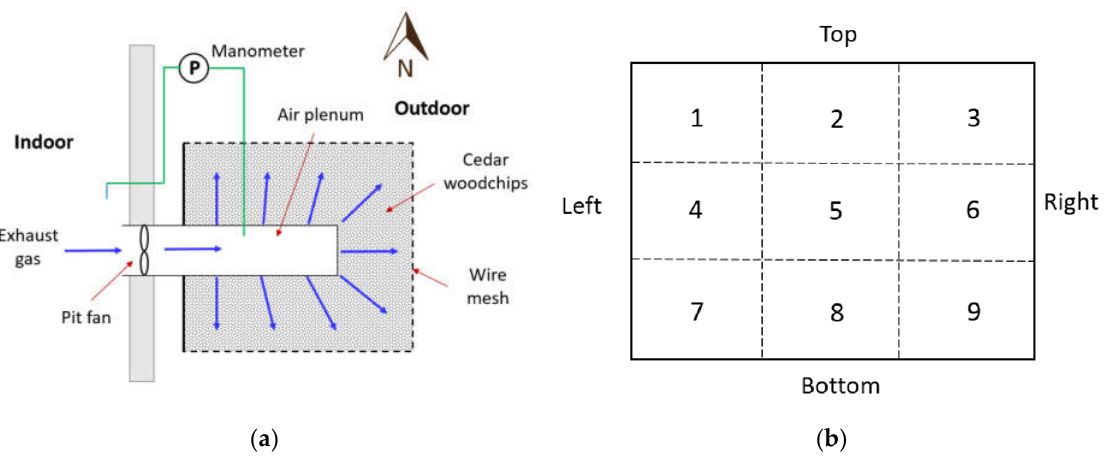
Figure 2. ( a ) Cross-section (top view) of each biofilter; and ( b ) side view of each biofilter. Both biofilters had the same orientation, each with three air outlet sides facing south, east, and north, respectively. Each side was divided into nine sections for measurement.